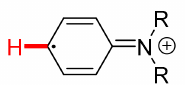
Figure 4. Para-radical cation intermediate.